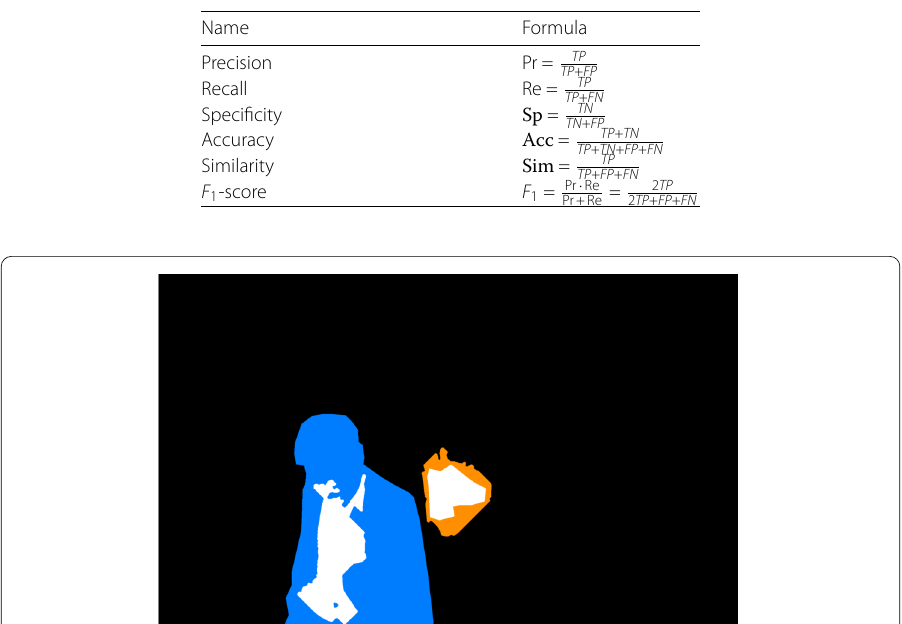
Figure 10 A predicted foreground-background mask. Here, the colored pixels are coded as follows: TP = white pixels, FP = orange pixels, TN = black pixels, FN = blue